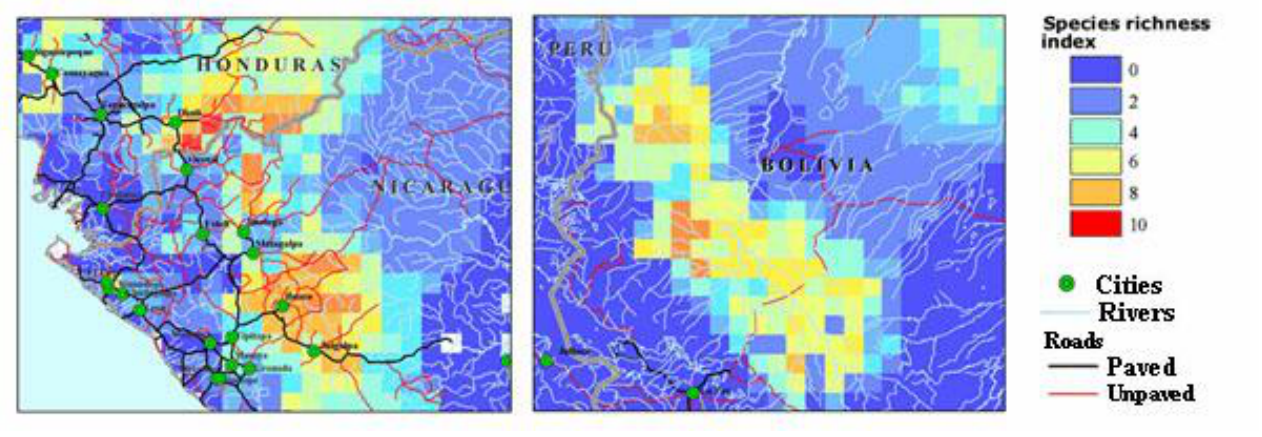
Fig. 7 . Details of areas selected in Central America and